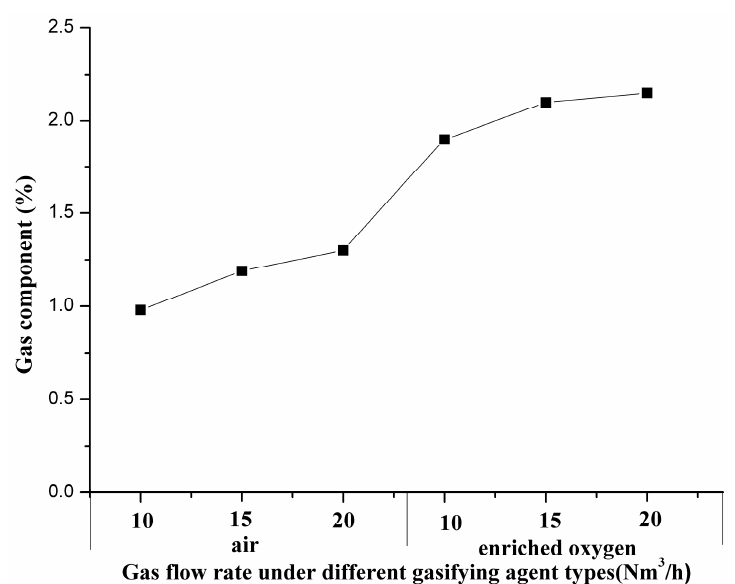
Figure 10. The gas components in the dry distillation zone with air and enriched oxygen as the gasifying agent at different flow rates during the reverse UCG process.